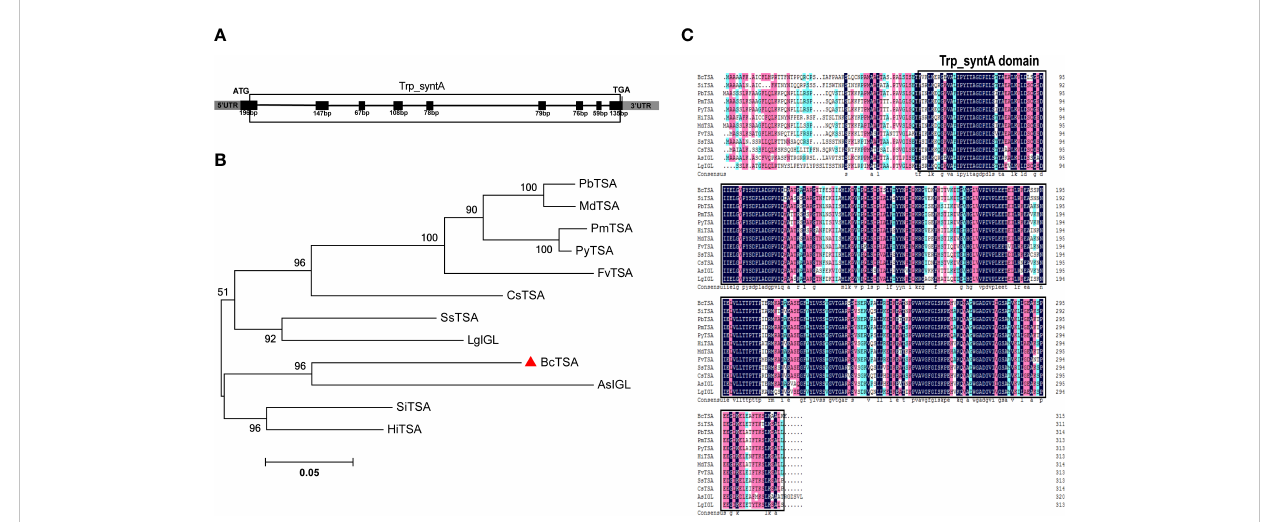
FIGURE 2 Molecular identi fi cation and phylogenetic analysis of BcTSA . (A) A schematic representation of the exon and intron organization of BcTSA . Black boxes indicate exons, intervening lines indicate introns. (B) Phylogenetic tree of BcTSA and other plant TSA proteins using MEGA 5.0 software based on the neighbor-joining method. (C) The homology comparison of amino acid alignment of TSA in 12 plant species. The Trp_syntA domain is